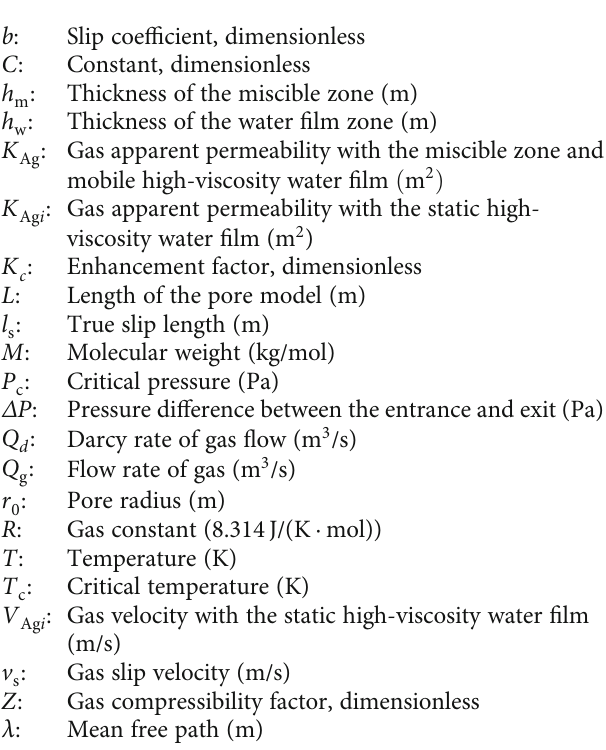
with Li et al. ’ s model [22]. T = 300 K, h w